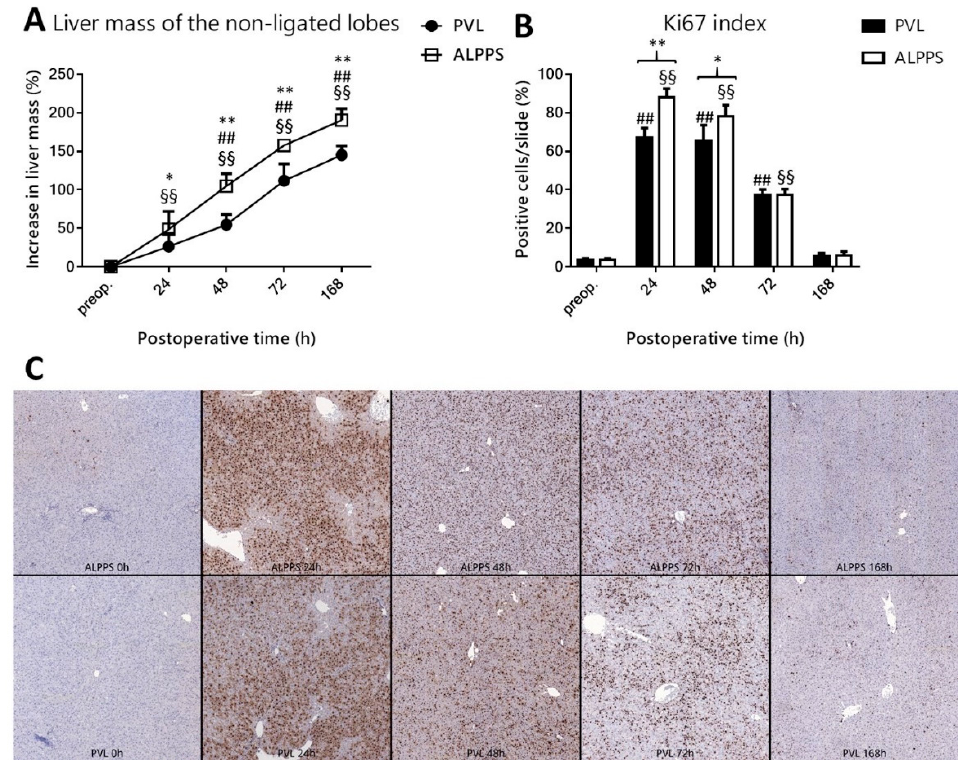
Figure 3. Effect of portal vein ligation (PVL) and associating liver partition and portal vein ligation for staged hepatectomy (ALPPS) on right medial lobe mass and hepatocellular proliferation. Increase in liver mass of non-ligated lobe ( A ) and Ki67 index ( B , C ) preoperatively (preop., 0 h), and at 24 h, 48 h, 72 h, and 168 h after PVL and ALPPS ( n = 6 per time point per group). * p < 0.050, ** p < 0.0010 versus PVL; ## p < 0.001 PVL versus corresponding controls (preop.); §§ p < 0.0010 ALPPS versus corresponding controls (preop.). Statistical analysis was performed with a two-way ANOVA and Tukey’s post hoc test. Data are presented as mean ± 1 standard deviation (SD).